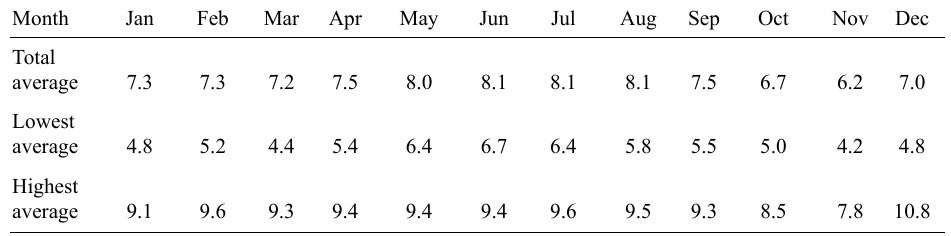
Monthly sunshine data (hours) for the period 1960 to